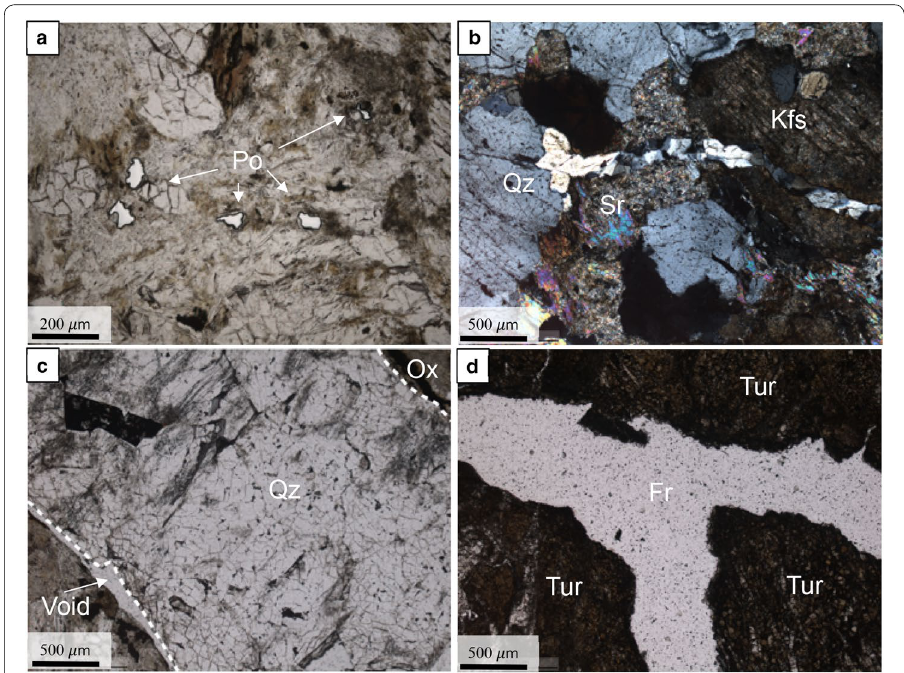
Fig. 8 Microscopic observations of thin‑section from the hydrothermalized zone. a Anatexite rich in veins. b Fractured anatexite. c Mineralized breach. d Porous breach. (Po) Porosity. (Qz) Quartz. (Void) Void. (Fr) Fracture. (Tur) Turmaline. (Ox) Oxide. (Sr) Sericites. (Kfs) Potassic